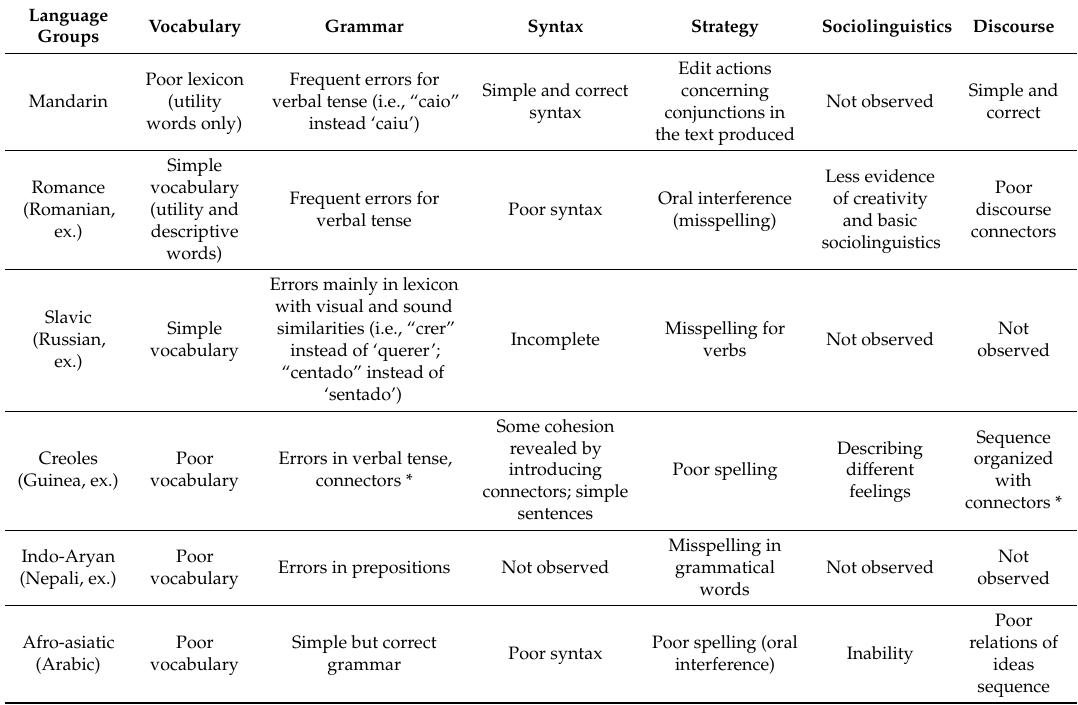
Table 3. Analysis of errors considering the six aspects of the writing